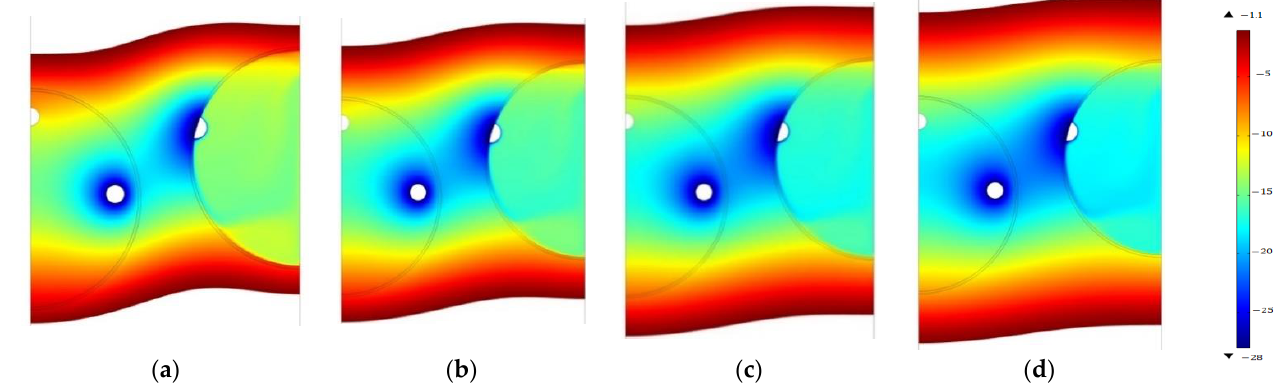
Figure 6. The freezing temperature distribution: ( a ) 30 days, ( b ) 40 days, ( c ) 50 days, ( d ) 60 days.